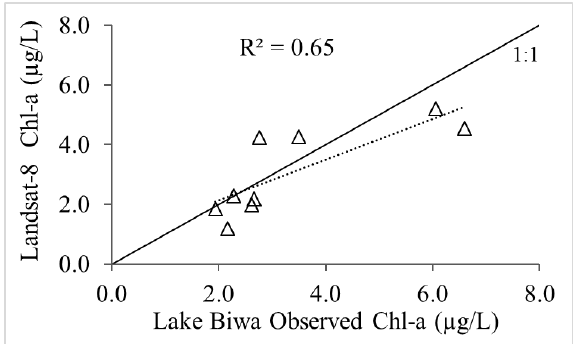
Figure 5. Estimated chlorophyll-a for Wakasa Bay coastal zone (Yura Estuary) using two different satellite sensors: (a) Landsat- Figure 3. Observed and Landsat-8 derived chlorophyll-a for 8 image and (b) Sentinel-2A image for August 2018. (Note: Lake Biwa (3 August 2018). ug/L represents microgram per